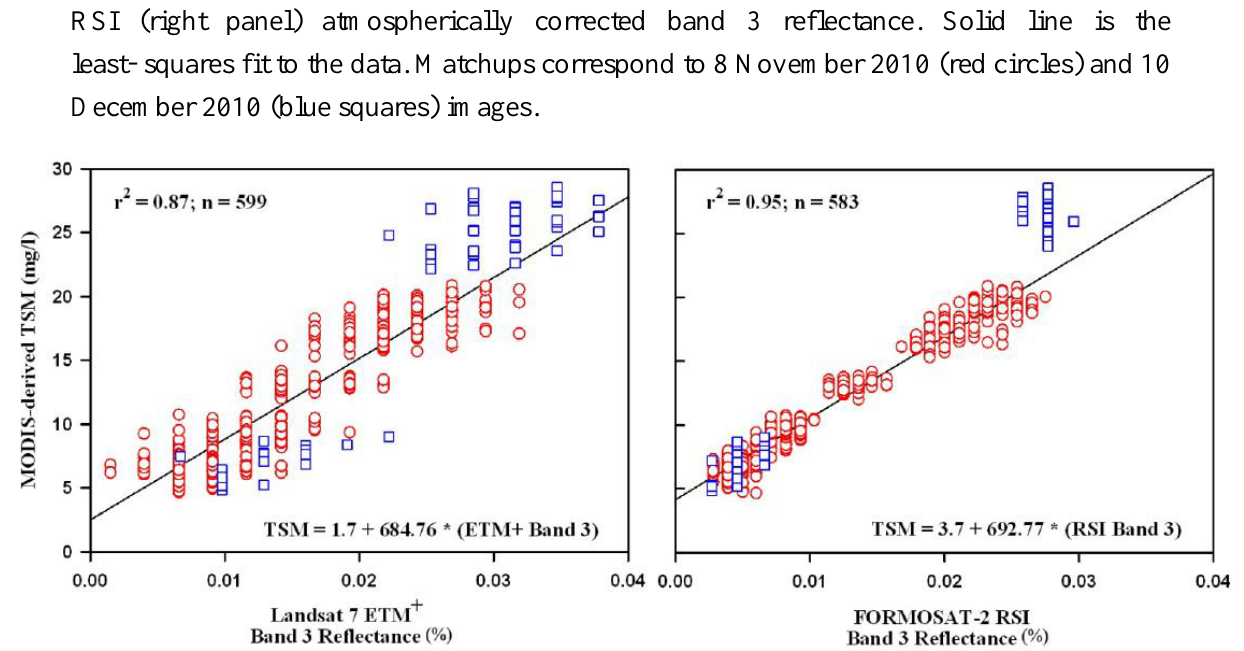
Figure 5. TSM concentrations mapped at three spatial resolutions for the Neuse and Tar Rivers and lower Pamlico Sound of the APES on 8 November 2010 using the MODIS Terra (250 m, upper left), Landsat 7 ETM+ (30 m, upper right) and FORMOSAT-2 RSI (8 m, lower left) sensors. The FORMOSAT-2 RSI image is a mosaic of two adjacent swaths imaged sequentially during one FORMOSAT-2 overpass. The lower right panel (zoomed image of red box) shows the high spatial detail in TSM concentration available using the FORMOSAT-2 RSI 8 m data that cannot be resolved by the other sensors. TSM concentration as shown in the FORMOSAT-2 RSI image is the same for all images. Land and clouds are masked